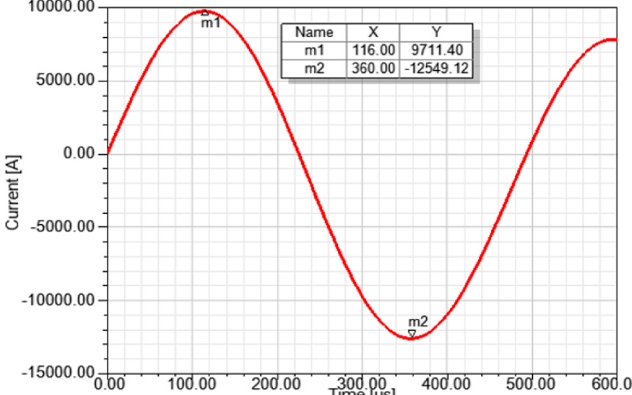
Figure 15. The secondary side current waveform with the optimization method.